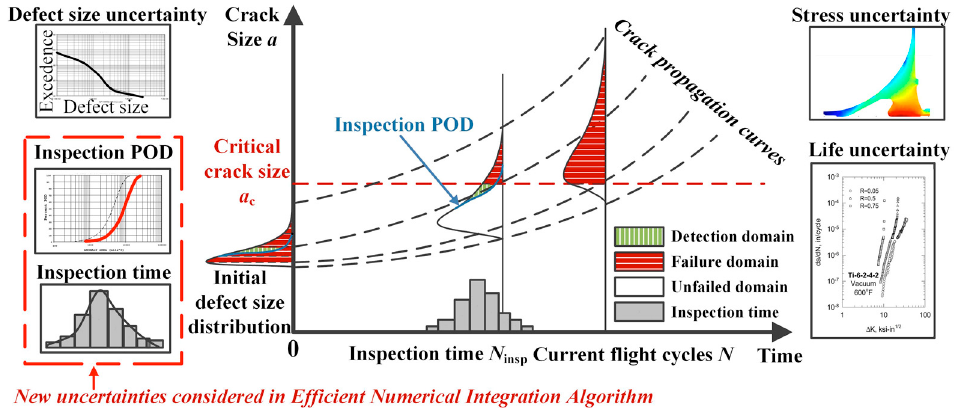
Figure 1. Schematic diagram of the stochastic dynamic system for risk assessment. For the PRA of the engine rotor disk, the oversize initial material defect (i.e., hard- α inclusion in titanium) is identified as the leading cause of the fracture of the rotor disk. This inclusion is hard and brittle, and all the defects are assumed to be circular cracks. Therefore, the crack initiation life is assumed to be equal to zero. Another assumption is the initial defect size distribution curve. The initial defect distribution shown in Figure 2 is based on a large amount of practical industrial experience developed by the American Aerospace Industry Association and the Rotor Integrity Subcommittee [27]. The distribution curve represents the number of initial defects greater than a specific length per million pounds of material.